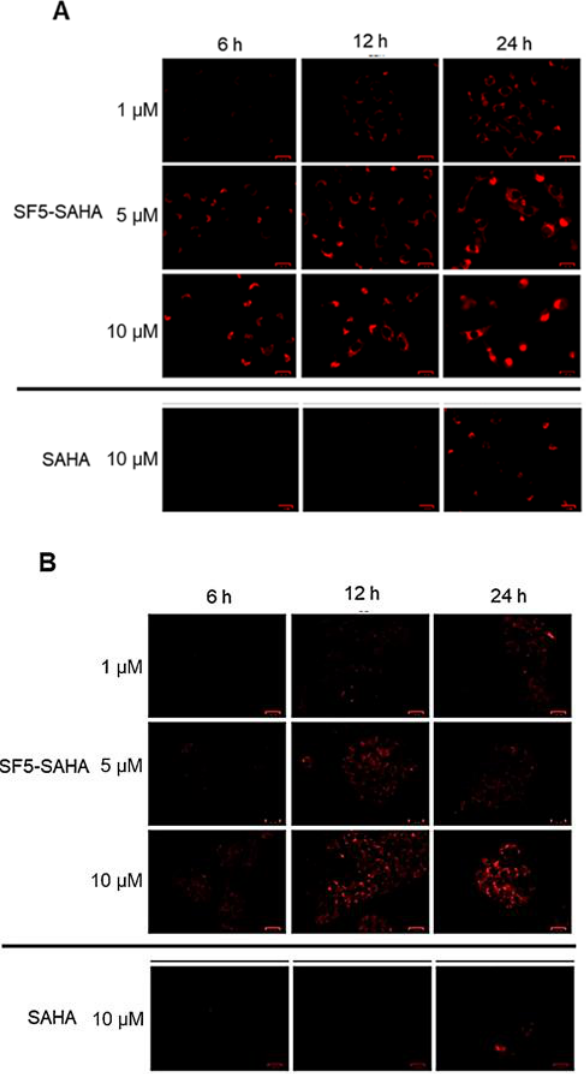
Figure 4. ROS induction (fluorescence microscopy using the ROS-dye CellROX orange) after 6 h, 12 h, and 24 h of incubation with SF5-SAHA and SAHA in DU145 ( A ) and Hep-G2 cells ( B ). Orange fluorescence indicates oxidation of the ROS-dye by formed